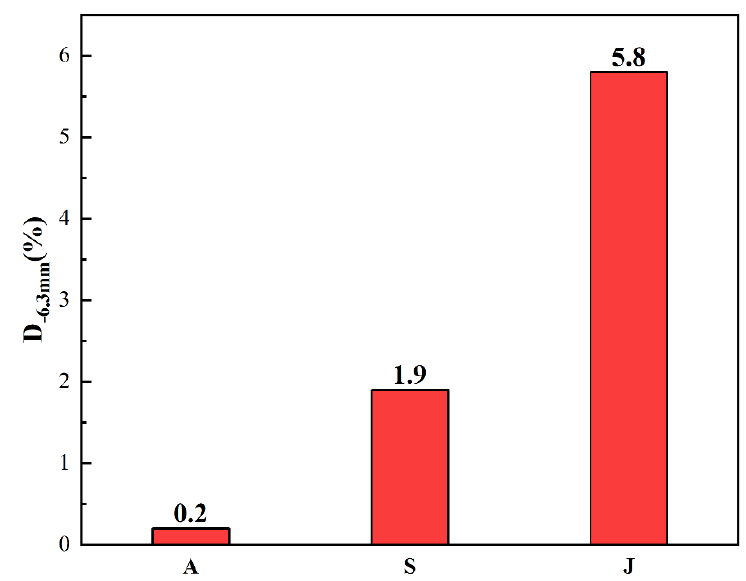
Figure 5. Decrepitation index of three types of lump ores.